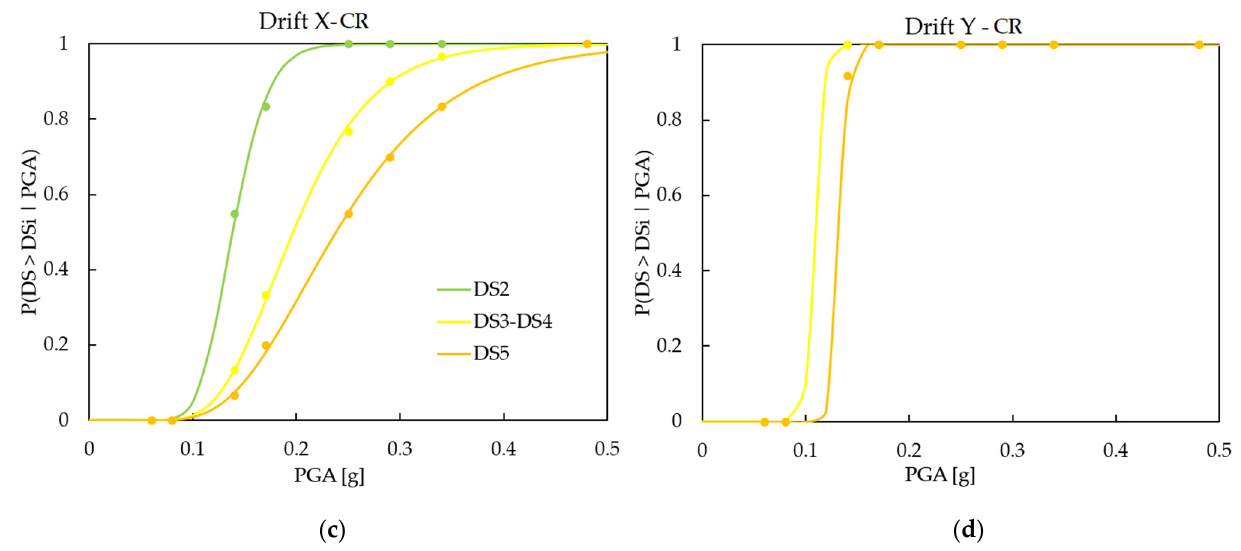
Figure 9. Fragility curves with damage thresholds defined according to HAZUS ( a , b ) and CR criterion ( c , d ) for X ( a , c ) and Y ( b , d ) directions.